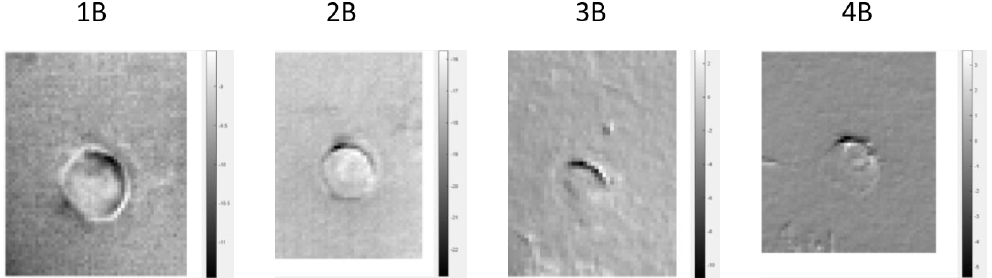
Figure 11. Snapshots taken from the principle component analysis of the thermal data of front induction heating.